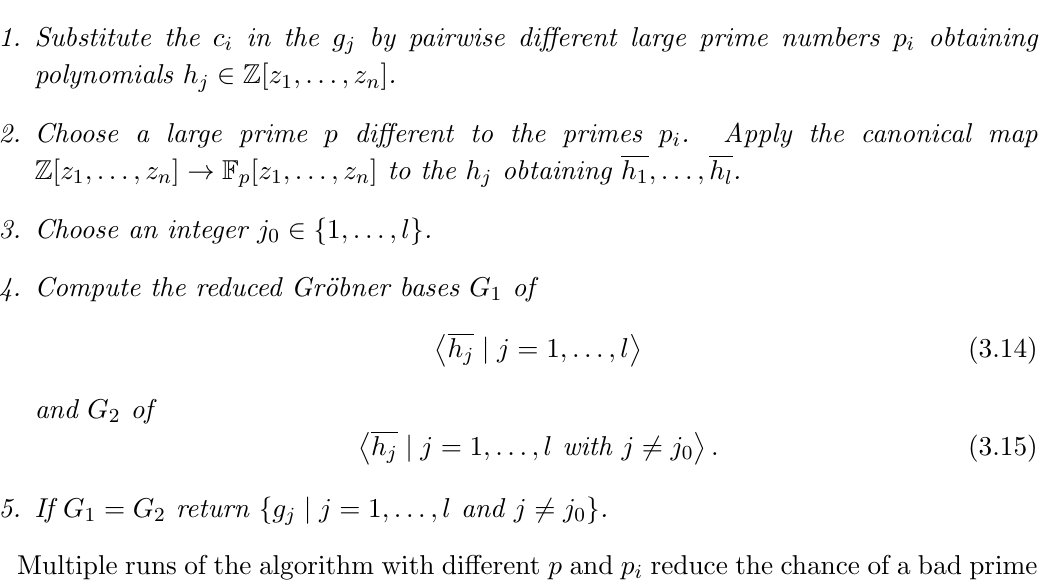
; : : : ; g of a submodule U (cid:26) A t 1 l ; : : : ; c ] , we proceed as 1 r